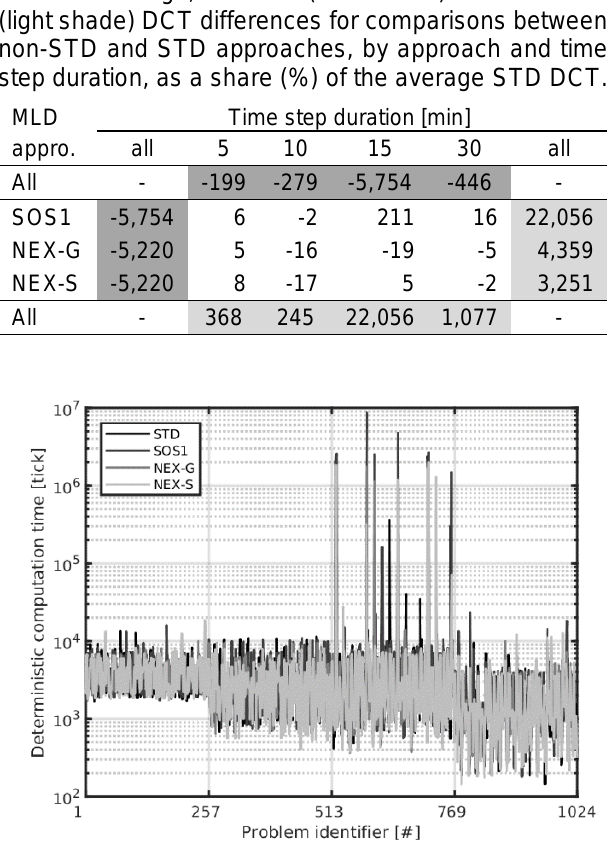
Figure 13 . DCT (y-axis) for each MLD control approach (z-axis), for each basic problem (x-axis) [problems # 1- 256, 257-512, 513-768, 769-1024 correspond to time step durations of 5, 10, 15 and 30 minutes].